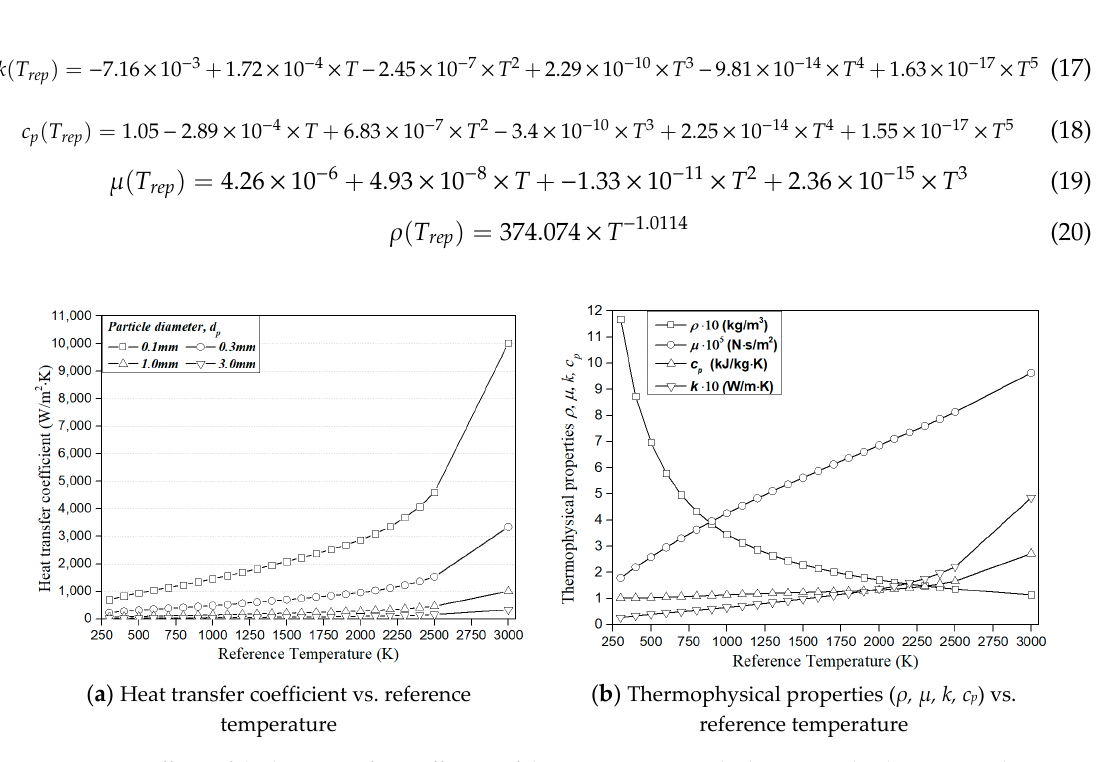
Figure 10. Effects of the heat transfer coefficient of the maximum particle dimeter and velocity Figure 10. E ff ects of the heat transfer coe ffi cient of the maximum particle dimeter and velocity according according to thermophysical properties ( ρ , μ , k, c p ). to thermophysical properties ( ρ , µ , k, c p